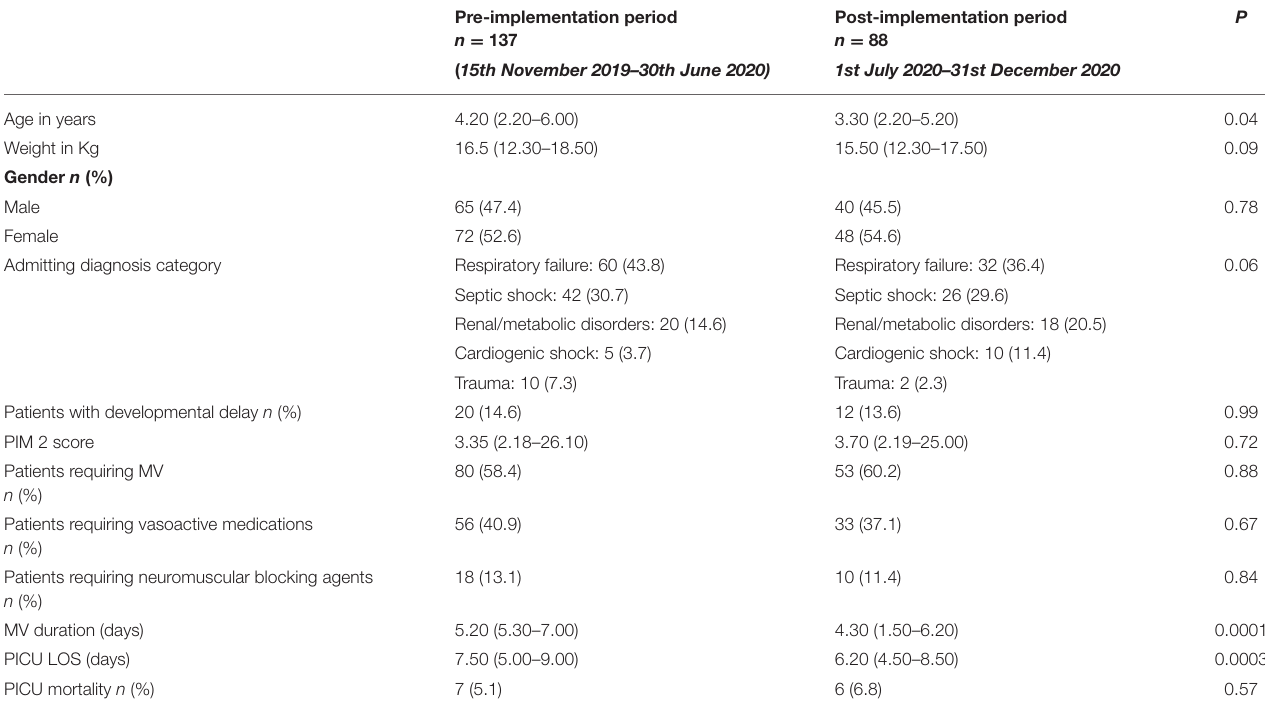
TABLE 1 | Patient